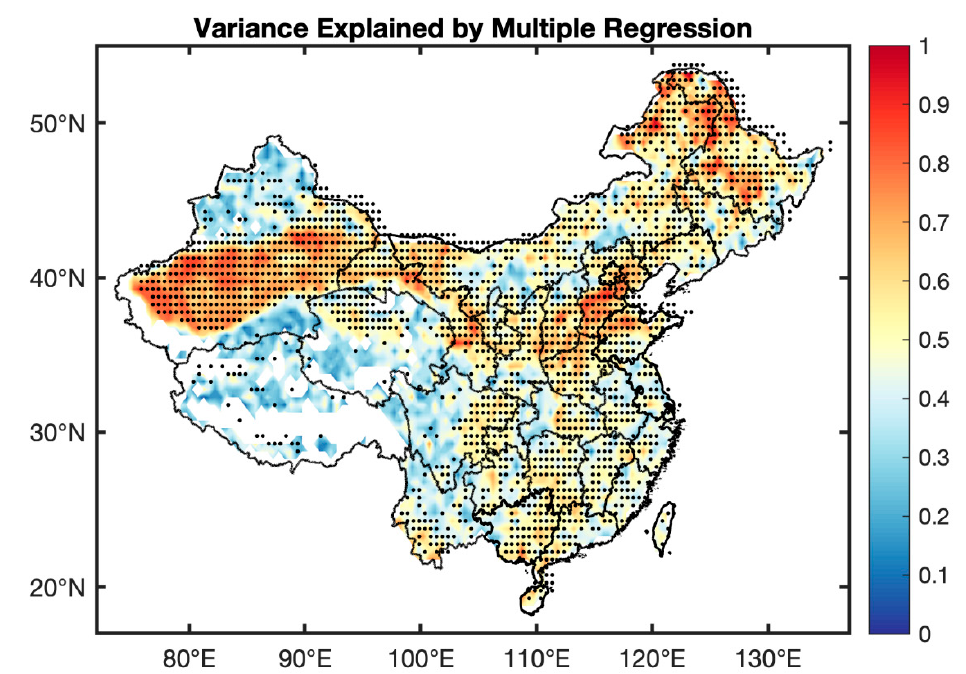
Figure 11. Variance of AOD explained by the multiple regression model against AAI, SO 2 , and NO 2 . The significance of the regression was tested using the F test and places passing the 95% significance level are marked by black dots.